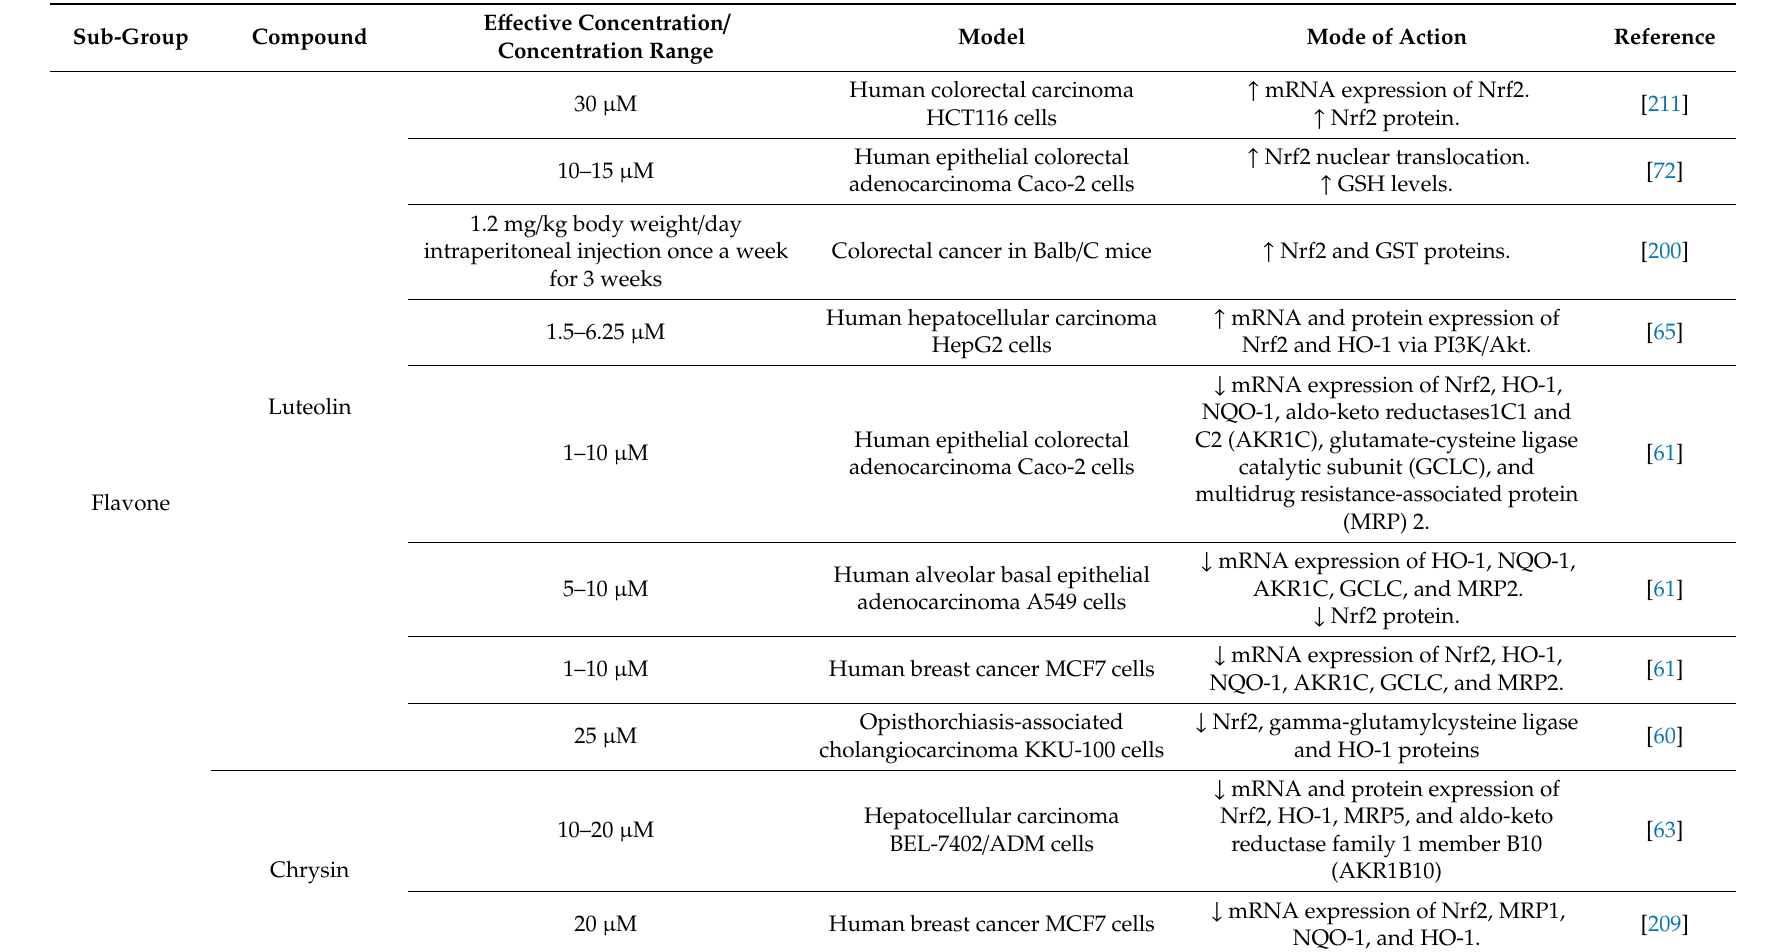
Table 2. Flavonoids: Nrf2 / ARE regulation in cancer